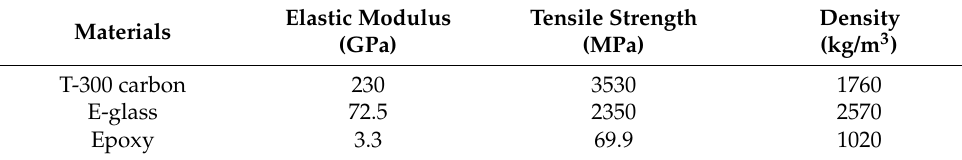
Table 1. Properties of carbon fibre, glass fibre, and epoxy resin at room temperature [36].